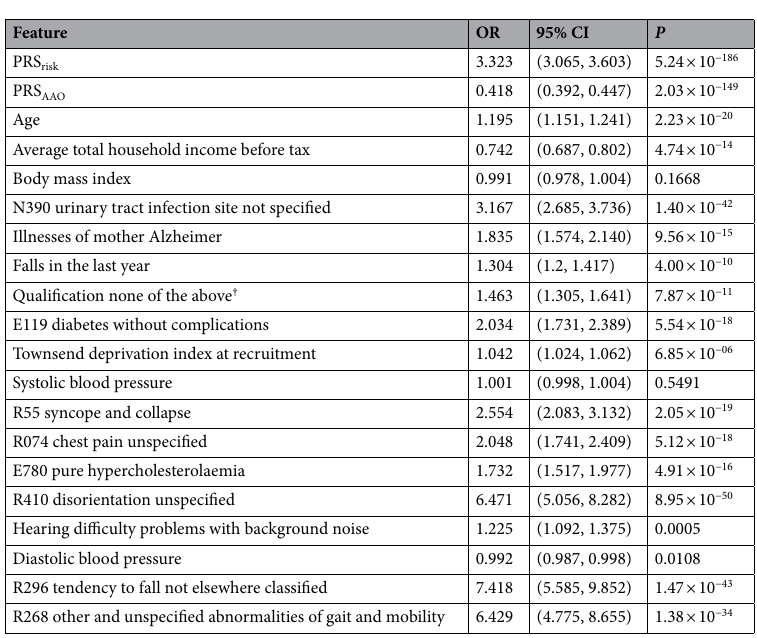
Table 4. Logistic regression for the top 20 features from XGBoost (age 65 +). Single-feature logistic regression with adjustment for age and sex. OR odds ratio. † None of the following: college or university, A levels/AS levels, O levels/GCSEs, CSEs, NVQ or HND or HNC, other professional qualifications, e.g. nursing and